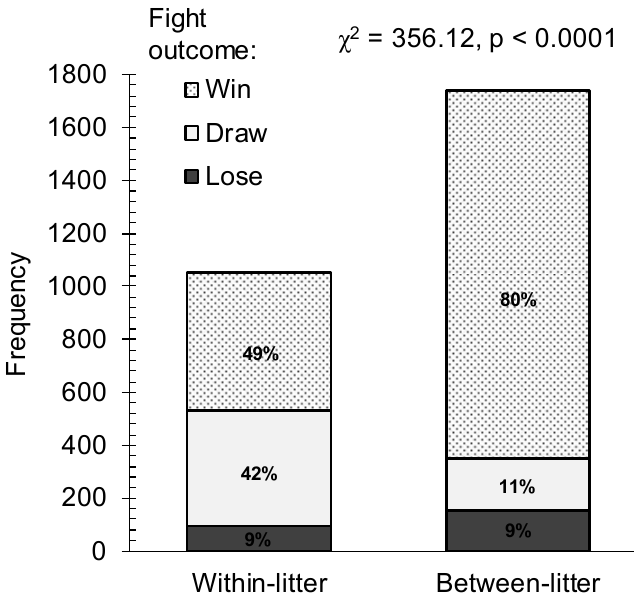
Figure 4. Outcome of fights—comparison of within- and between-litter interactions.